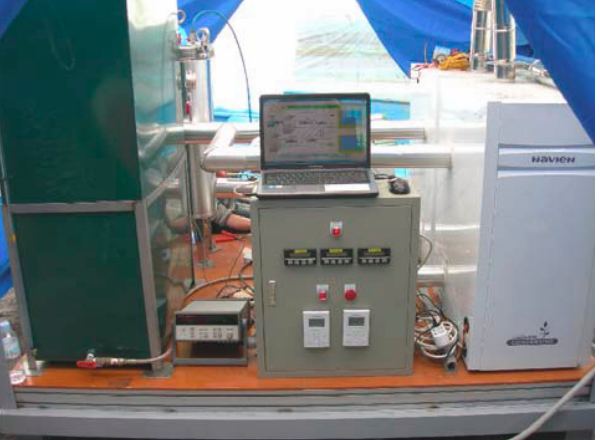
Figure 3. Experimental apparatus of a standing column well (SCW) system.